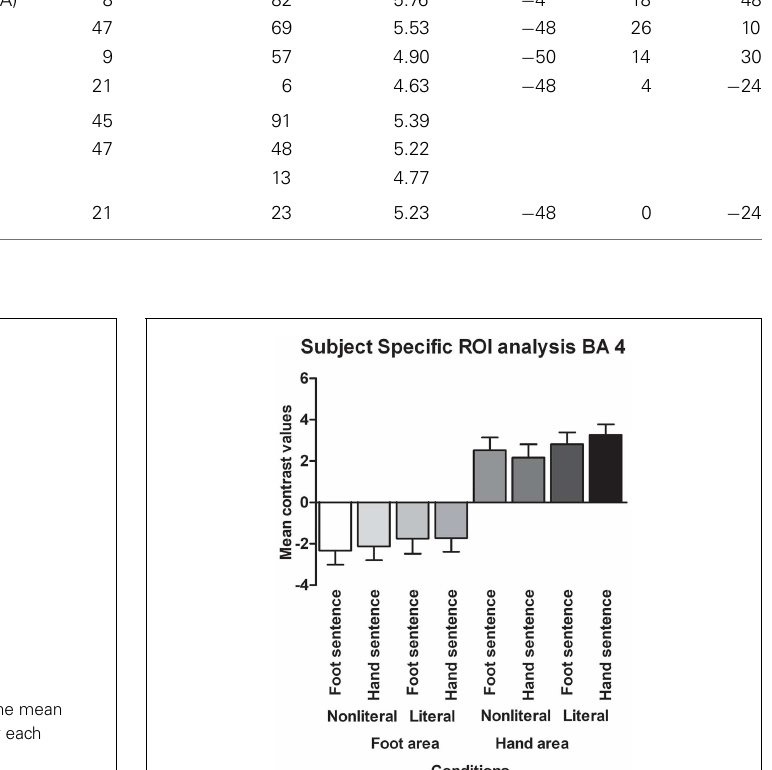
colorful figurative language (Proverbio et al., 2009). This contrast did not activate any motor regions. The contrasts “literal foot” > “non-literal foot”, “literal hand” > “non-literal hand”, “hand” > “foot”, and the reversed contrasts did not activate any regions at p < 0.001